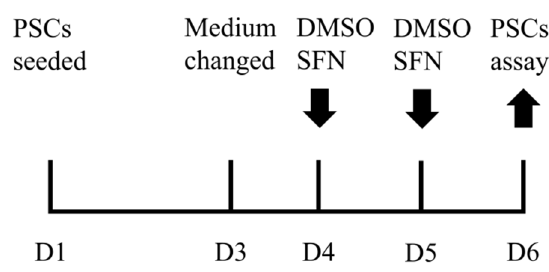
Figure 1. PSC culture and SFN treatment procedure.